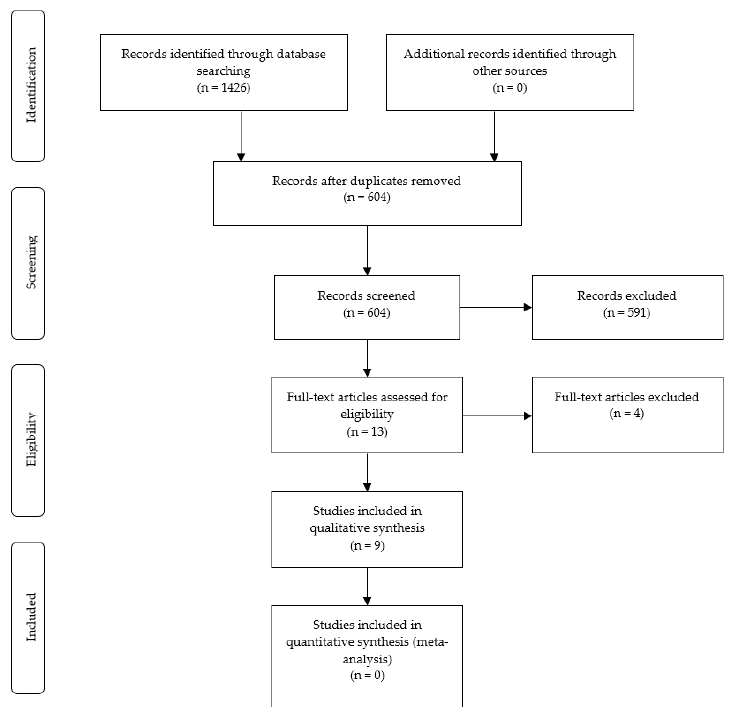
Figure 1. PRISMA Flow Diagram.